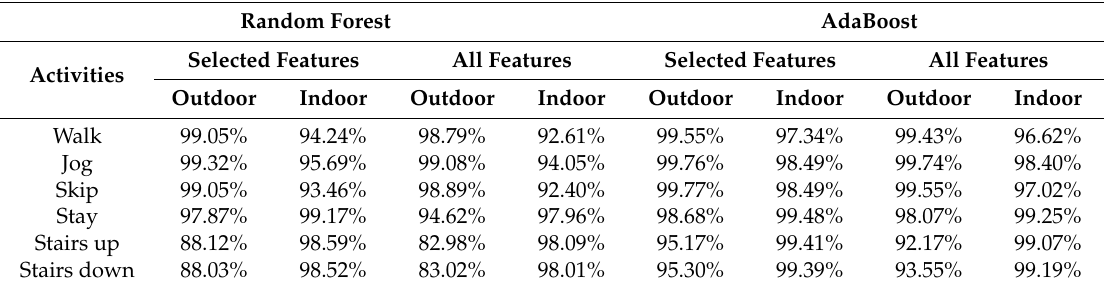
( b ) Figure 9. ( a ) The precision-recall graph and ( b ) the ROC graph of the RF model for the climbing stairs dataset in the selected-features scenario.